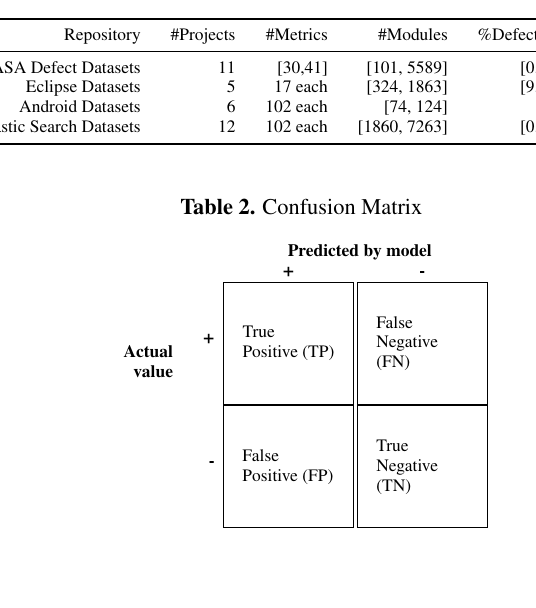
Table 1. Summary of the datasets employed